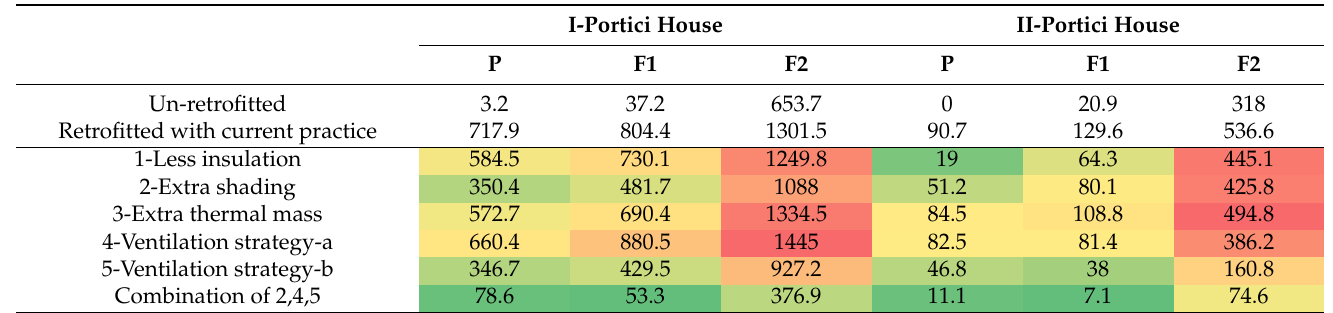
Table 10. Annual overheating hours of living rooms for each adaptation option, for each reference building, under each time period. For each reference building, the colour of tables switches from green to red according to the increment in numbers.